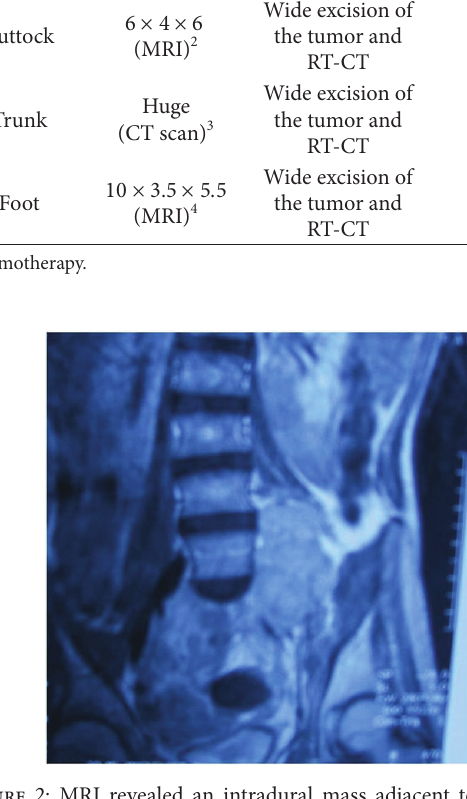
Figure 2: MRI revealed an intradural mass adjacent to the fifth lumbar vertebra, multiple pre- and paraspinal masses, and multiple masses of the left